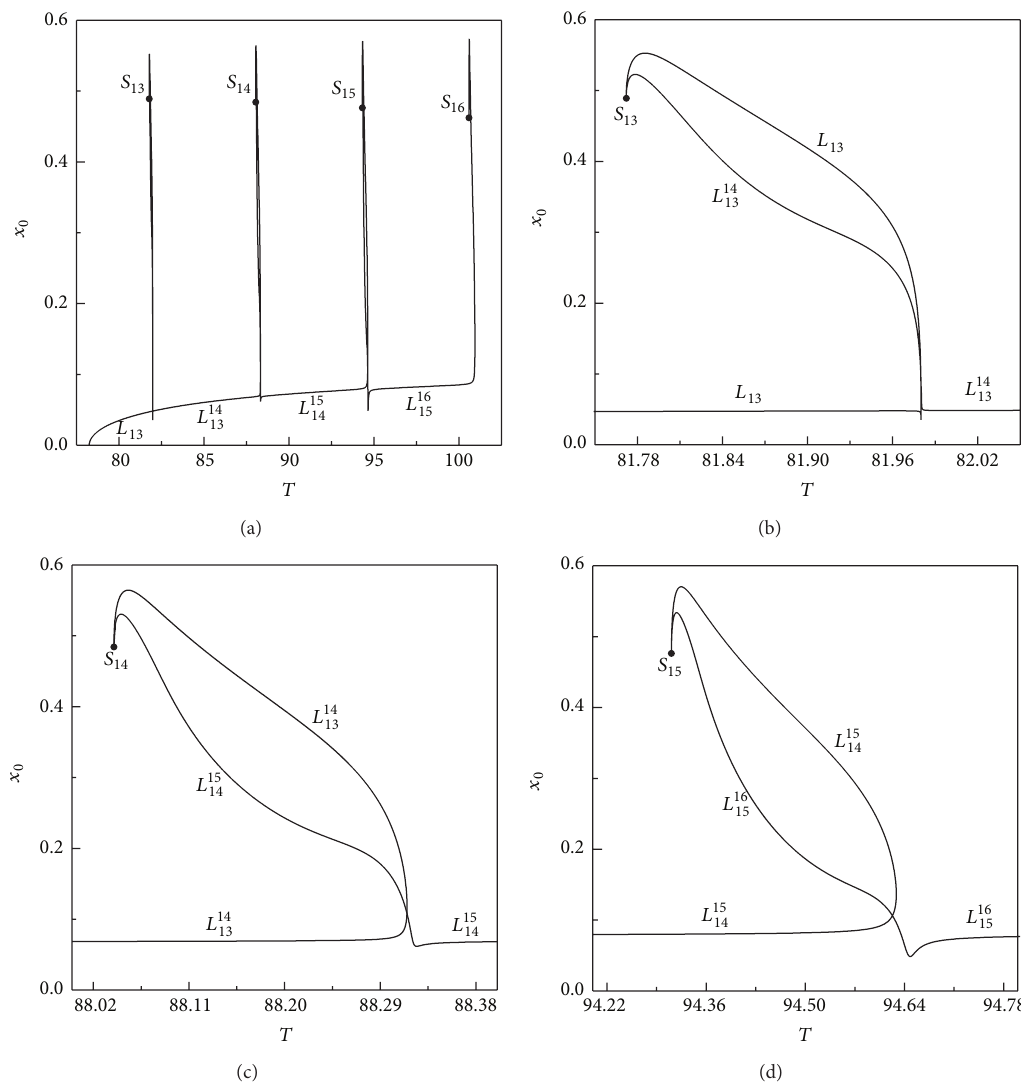
Figure 9: (a) Projection of the characteristic curve of the long period family in the (𝑇,𝑥 0 ) plane. (b), (c), and (d) appropriate magnifications of certain parts of